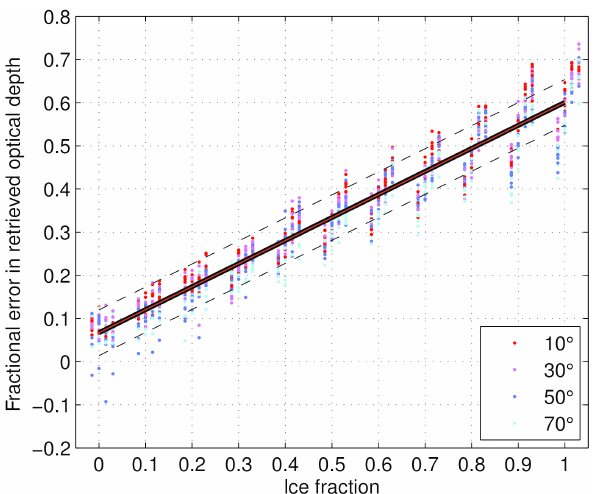
Figure 5. Fractional error in the retrieved optical depth, calculated as (τ ret − τ true )/τ true , for the idealised cloud columns as a function of the prescribed ice fraction (horizontal axis) and solar zenith an- gle (colours; see legend). The four columns of points around each 0.1 interval in ice fraction indicate the distributions of fractional er- ror across the four values of ice effective diameter (25, 35, 55 and 100µm from left to right). A linear fit through the points is shown (solid line), along with an estimate of its uncertainty (dashed